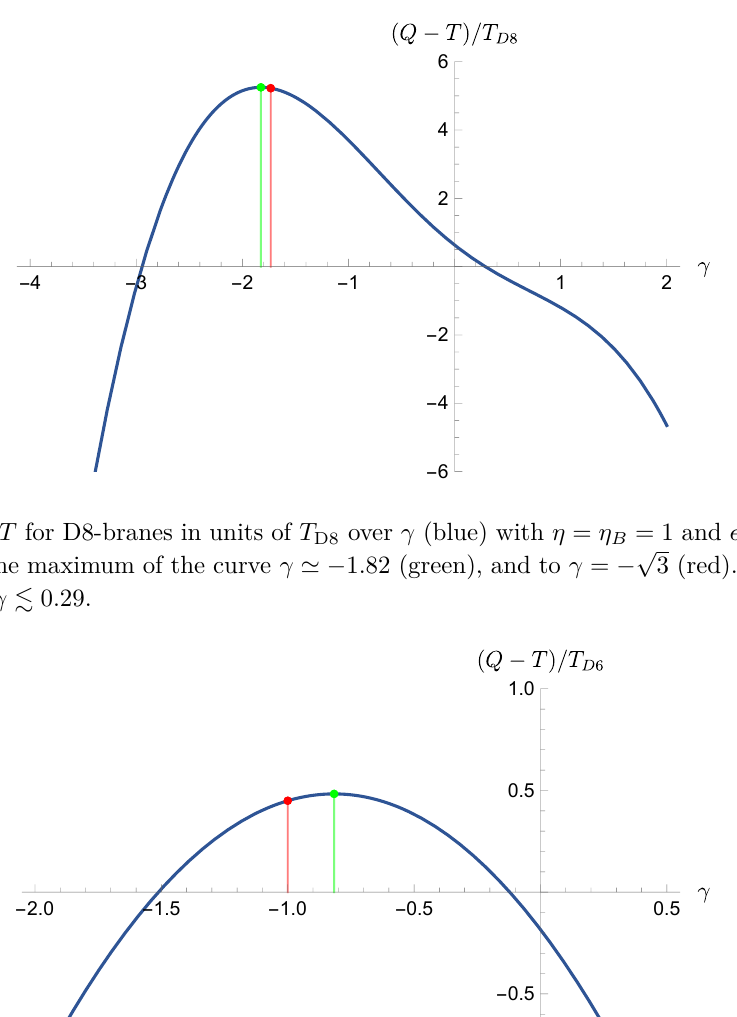
Figure 2 . Q − T for D6-branes in units of T D 6 over γ (blue) with η = η B = 1 and (cid:15) = 0 . The dots correspond to the maximum of the curve γ = − p 2 / 3 (green) and to γ = − 1 (red). Q > T for the range − 1 . 51 . γ . − 0 . 12